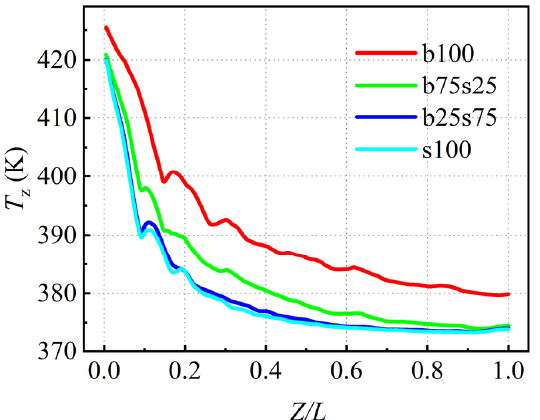
Figure 19. Temperature distributions along the axial direction of different packed